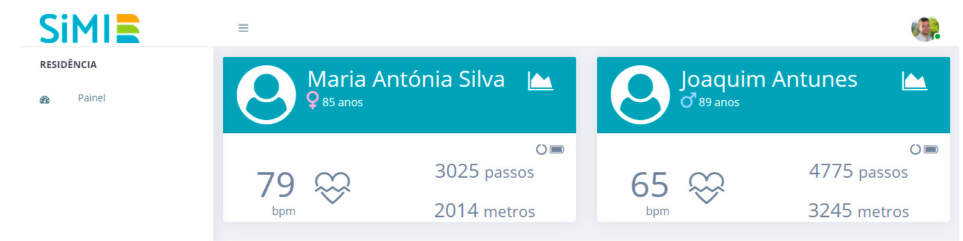
Figure 13. Web platform with the elderly’s